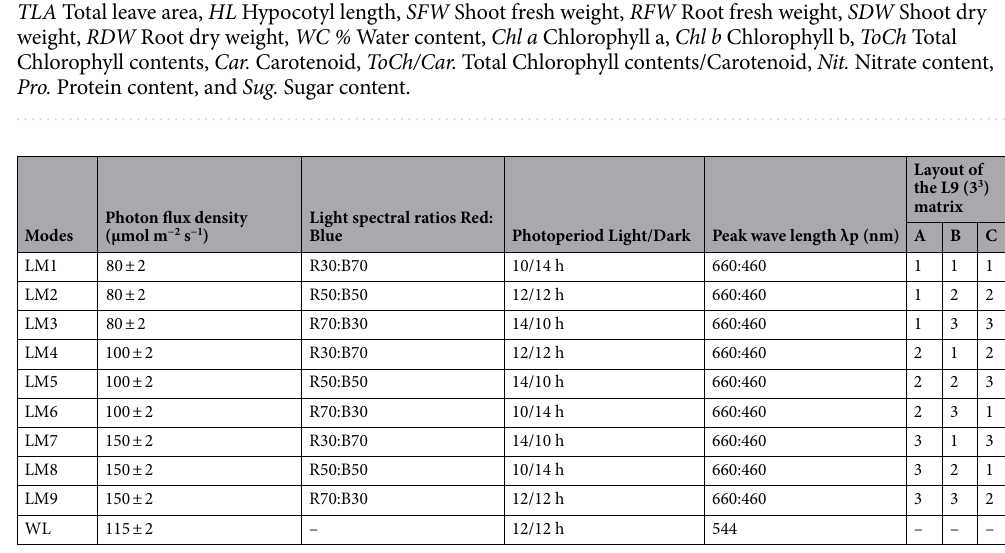
Table 4. Parameters of the LED light properties used in the study.